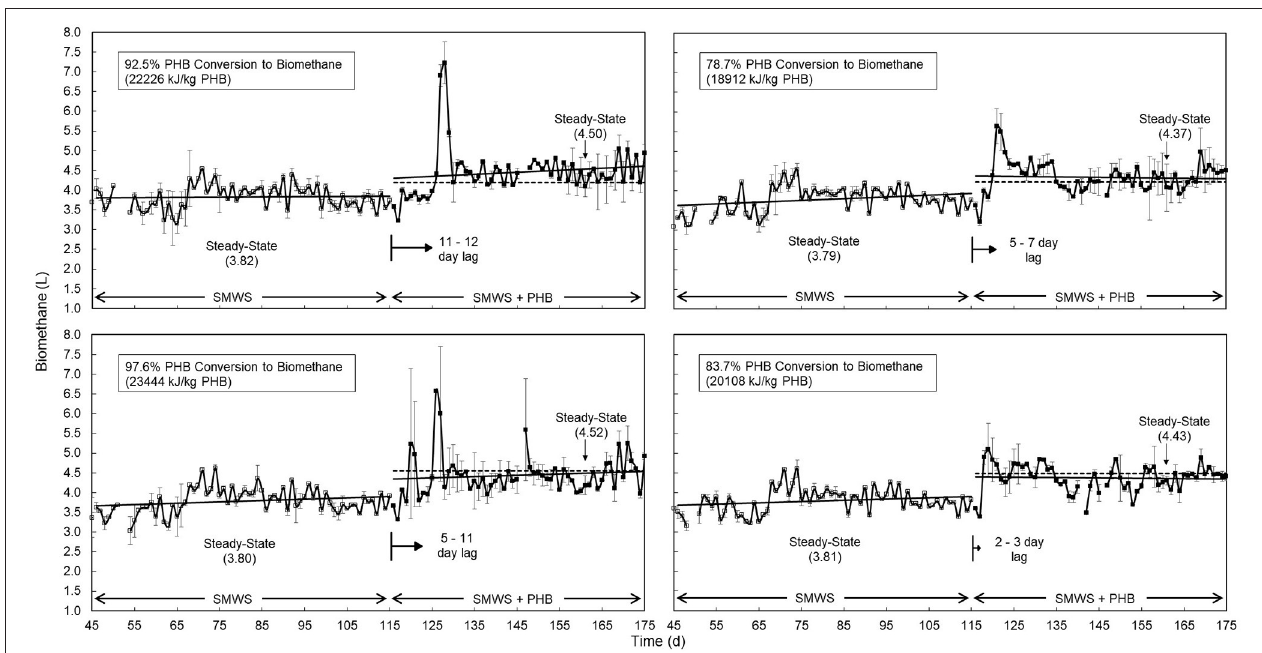
FIGURE 4 | Anaerobic digester daily biomethane production ( n = 2, error bars show standard deviation) comparing (top, left) untreated PHB1, (bottom, left) pretreated PHB1 (treatment: 55 ◦ C, pH = 12, 24h) and (top, right) untreated PHB2, (bottom, right) pretreated PHB2 (55 ◦ C, pH = 12, 48h). Quasi steady state was assumed after 45 days with average biomethane production (L/d) at quasi steady state presented in parentheses. Solid lines depict gas production rates before and after PHB co-digestion, dotted lines show theoretical co-digestion production based on 40 days BMPs. Solid arrows proportionately illustrate average lag period (d) between PHB addition and increased biomethane production. Steady state conversion of PHB to biomethane (%) and higher heating value of methane per kg PHB was based on an expected 21% increase in biomethane yield.